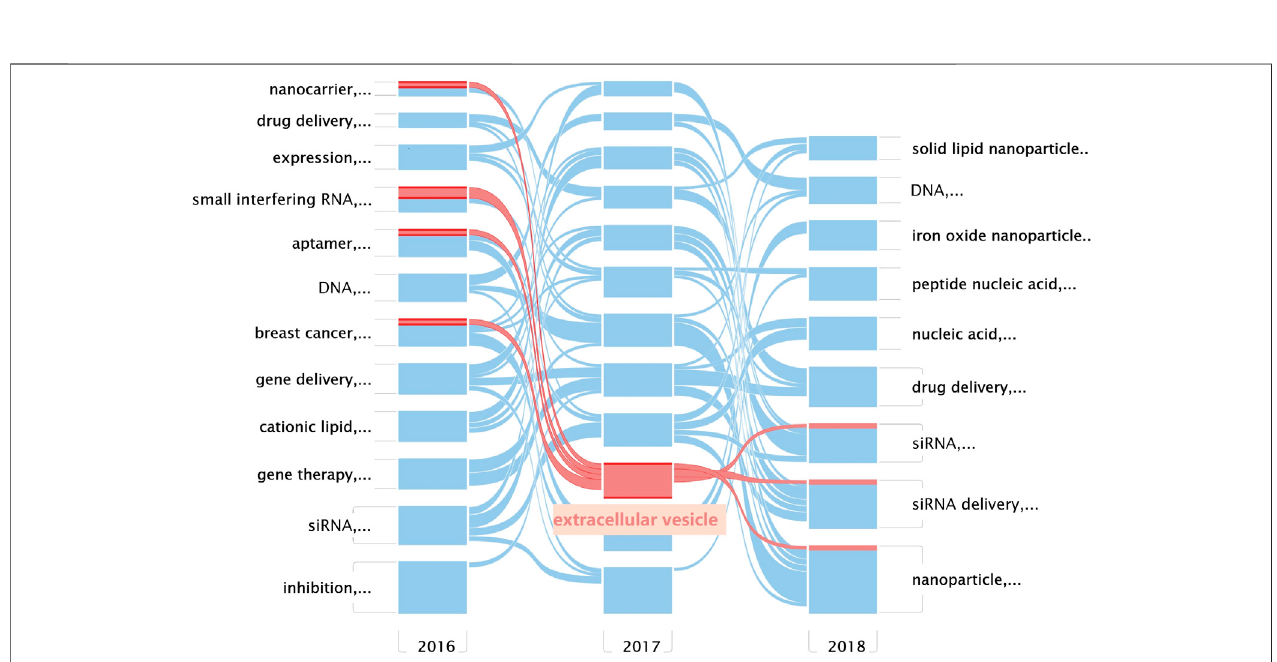
FIGURE 4 | Alluvial fl ow diagram of nanoparticles in nucleic acid – targeted delivery. Networks are clustered and simpli fi ed by year, and streamlines connect the samenodesbetweenyears.Everyrowinthis fi gurerepresentsakeywordco-occurrencenetworkcorrespondingtotheslicedyear;blocksrefertoclustersofwordsand are named by the most crucial keyword in each cluster; and the lines connect the same keyword in separated years to observe changes in the concepts over time.